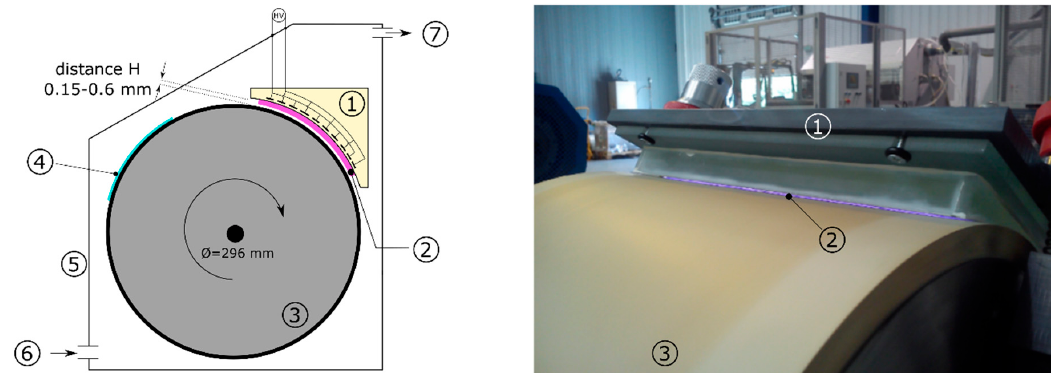
Figure 1. Reactor based on diffuse coplanar surface barrier discharge (DCSBD) with concavely curved alumina ceramics for roll-to-roll treatment of flexible substrates. 1—Concavely curved DCSBD unit; 2—DCSBD plasma; 3—roller; 4—sample; 5—reactor chamber; 6—gas inlet; 7—gas